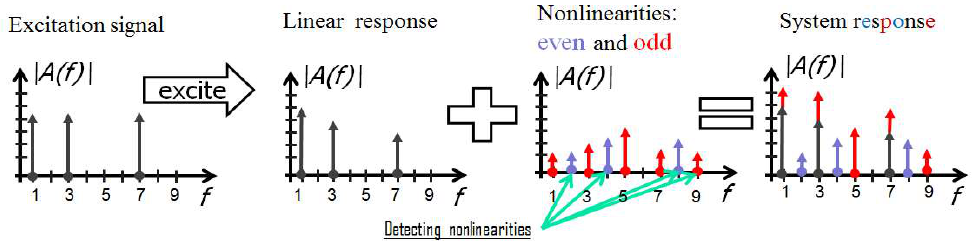
Figure 12. System response including linear (black) and nonlinear (blue: even nonlinear distortion, red: odd nonlinear distortion) elements.